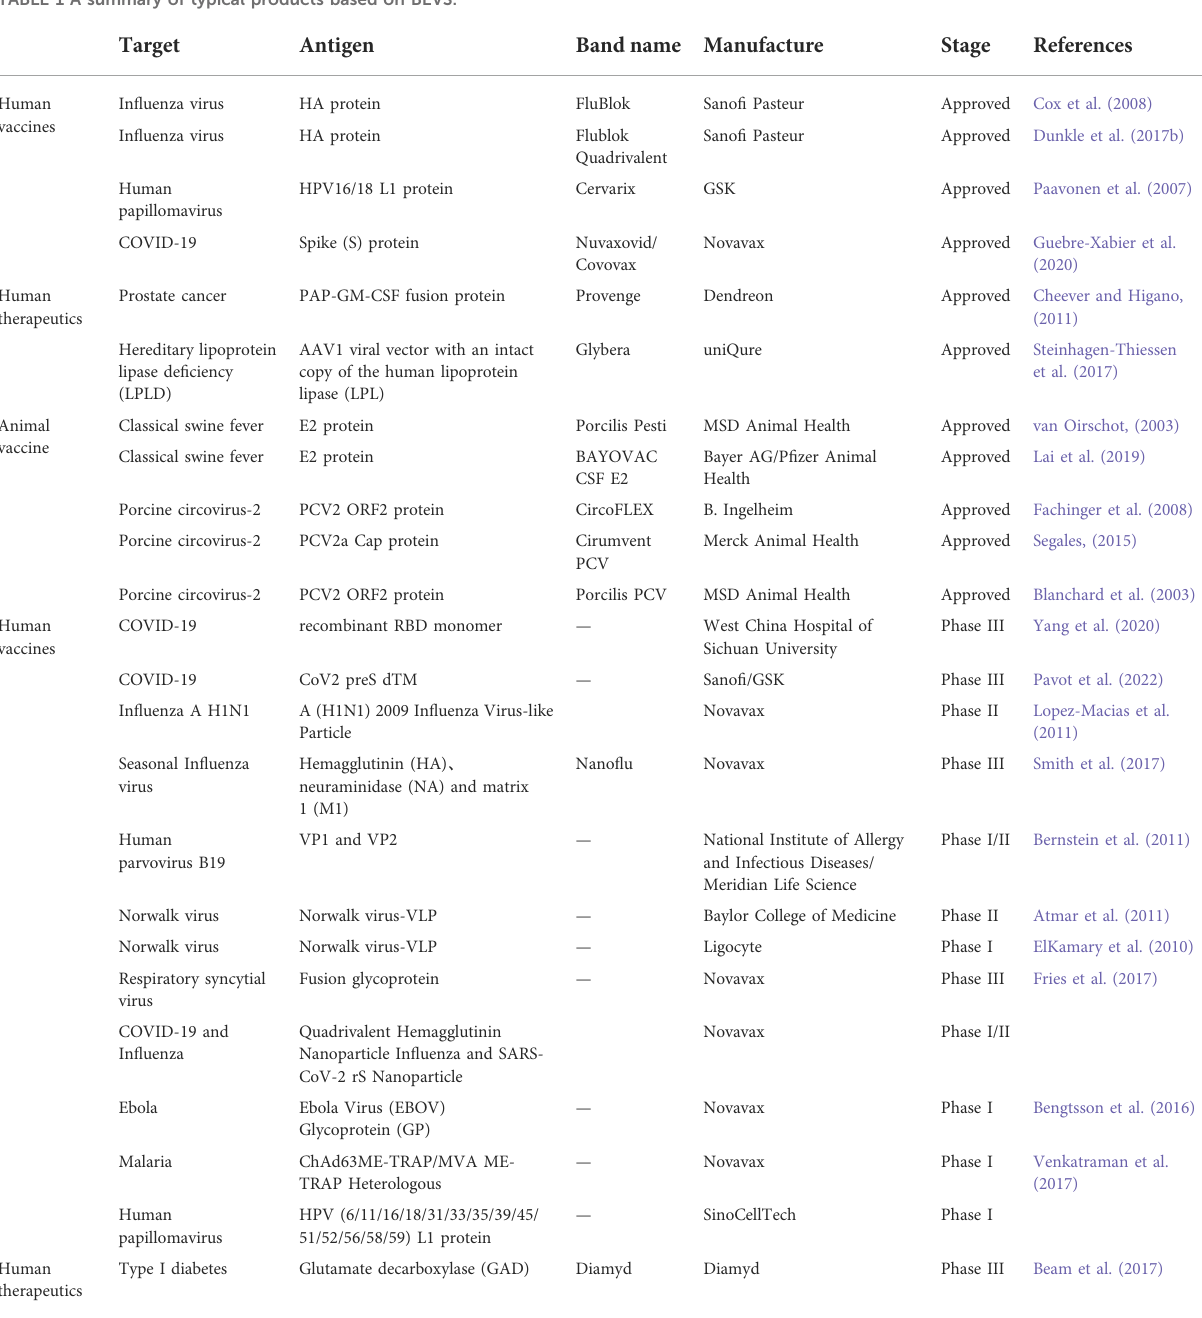
TABLE 1 A summary of typical products based on